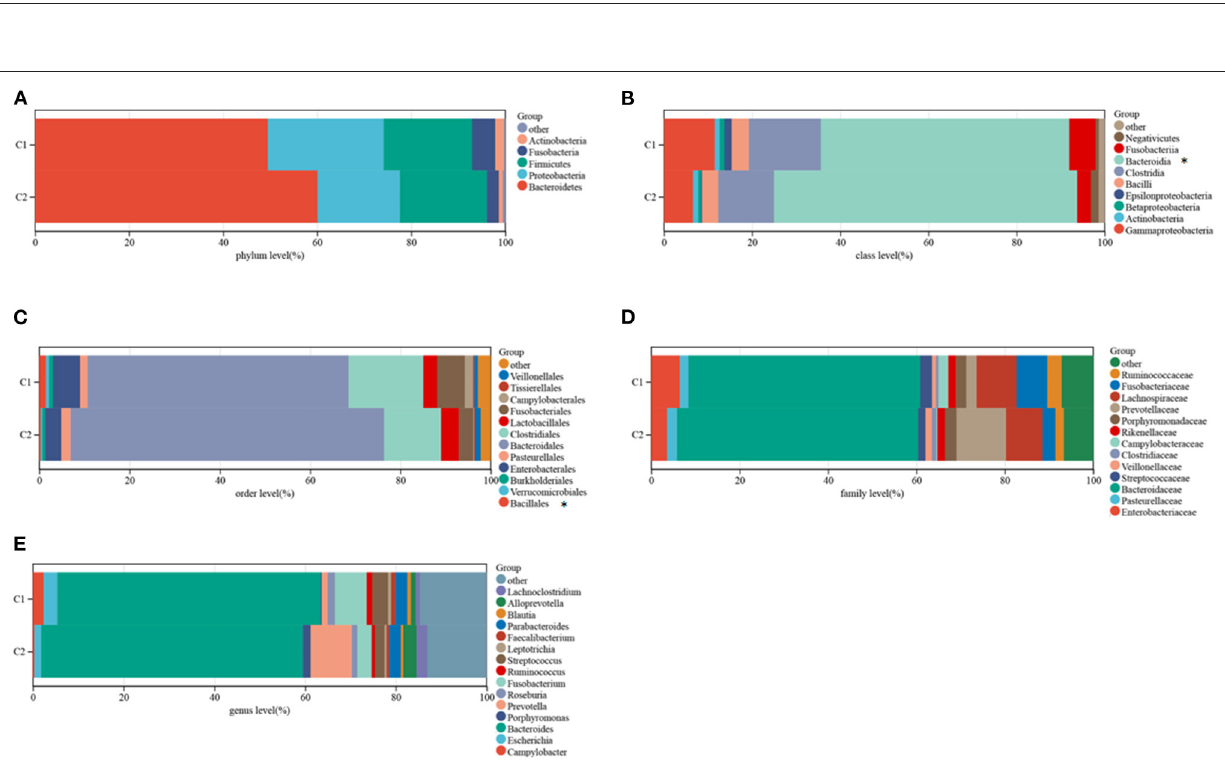
Frontiers in Medicine |